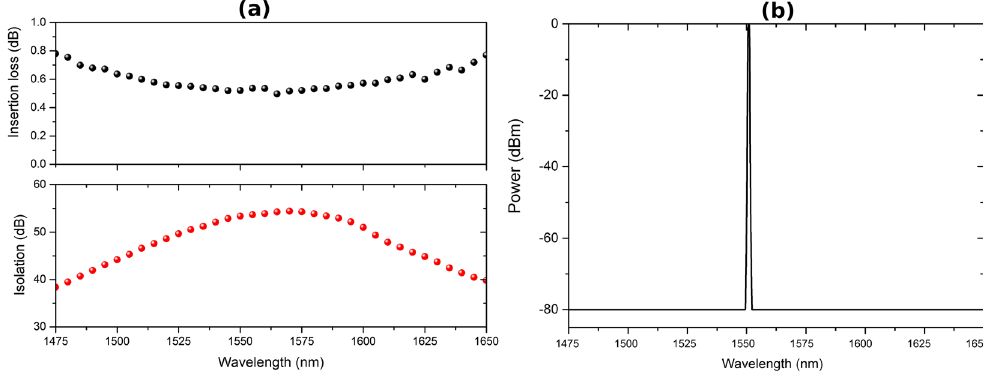
Figure 7. Optical performance of ( a ) isolators and ( b ) wavelength filters, used to provide protection against Trojan horse